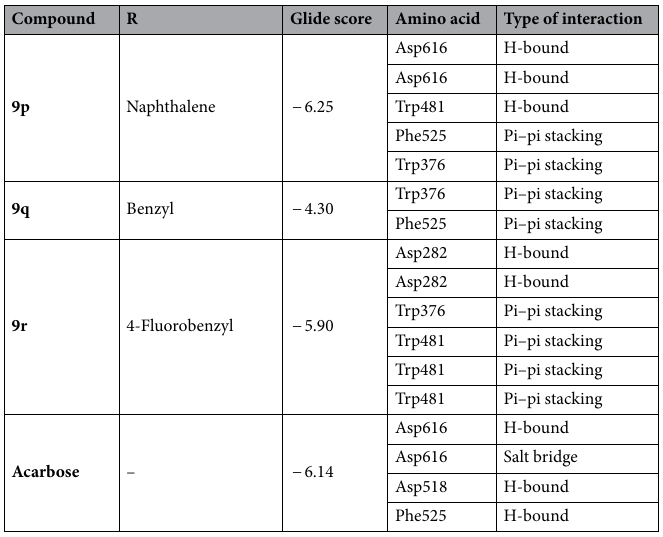
Table 2. Docking scores and interactions of compounds against the α-glucosidase (PDB ID: 5NN8).